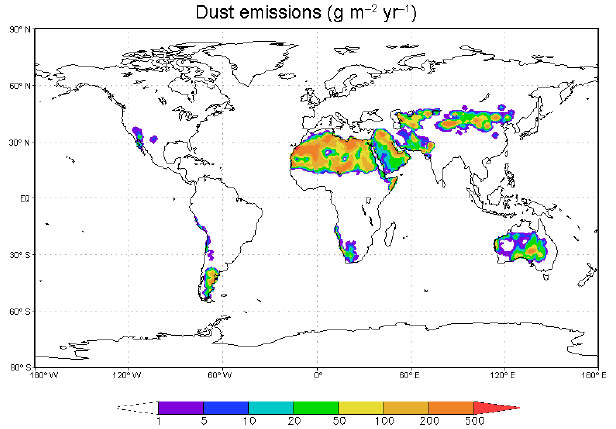
Figure 4. Annual dust emissions (in gm − 2 yr − 1 ) over the Septem- ber 2012–September 2013 period.